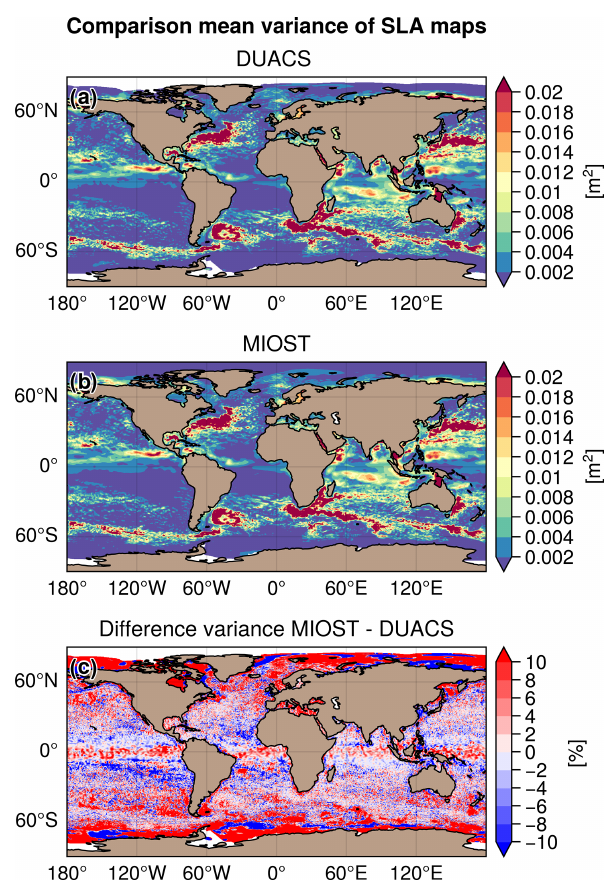
Figure 6. Variance (in m 2 ) of sea-level anomaly maps constructed with (a) the DUACS approach, (b) the MIOST approach, and (c) the difference between the MIOST and DUACS variance maps ex- pressed in